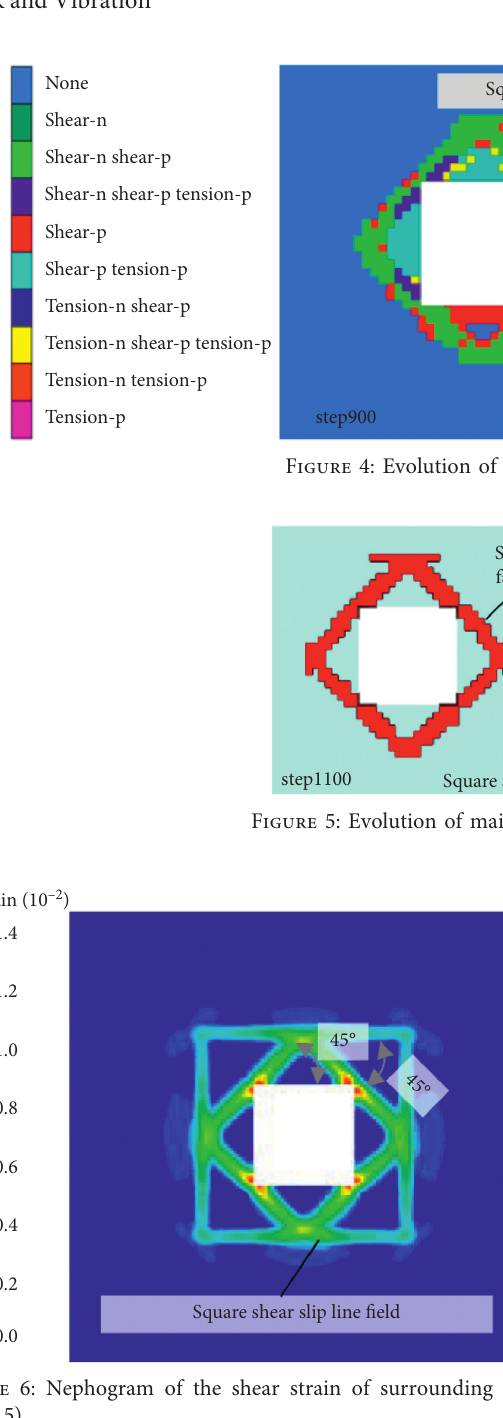
Figure 7: Nephogram of the shear strain of surrounding rock ( Ic �